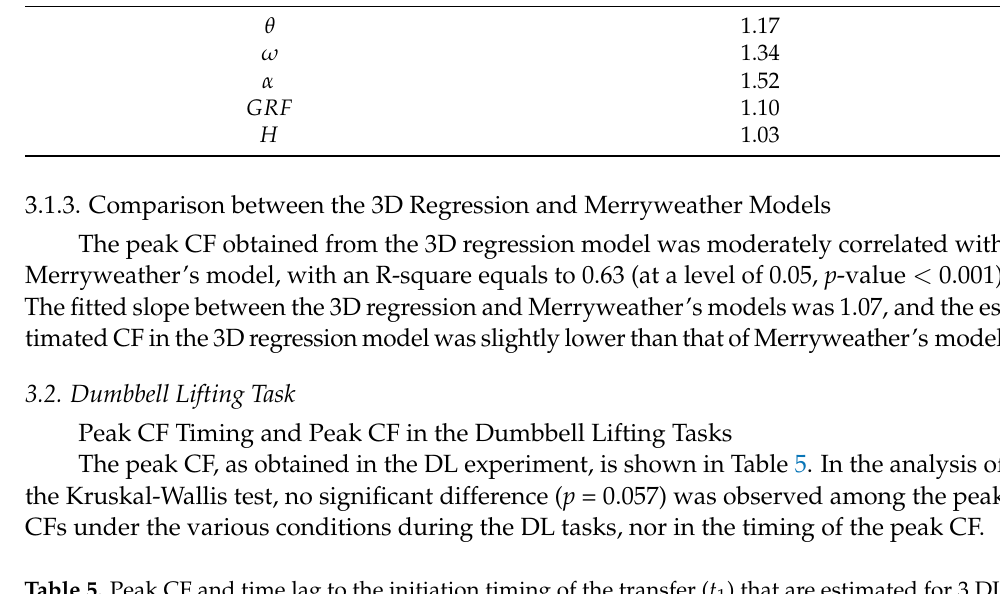
Table 5. Peak CF and time lag to the initiation timing of the transfer ( t 1 ) that are estimated for 3 DL patterns (15 kg dumbbell under com/t-e/e-t